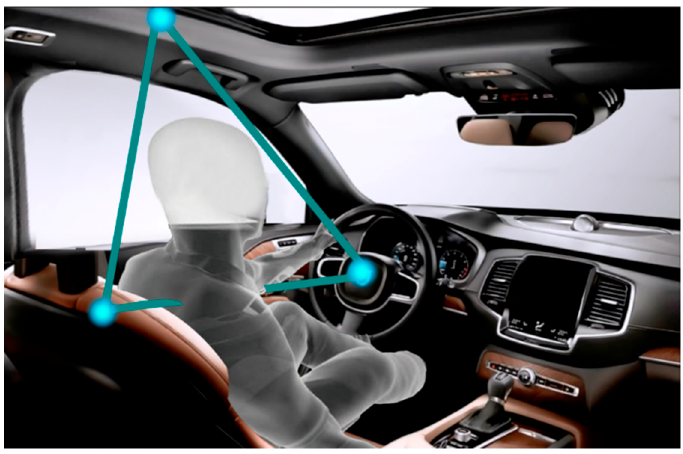
Figure 1. Driver’s respiration detection system.